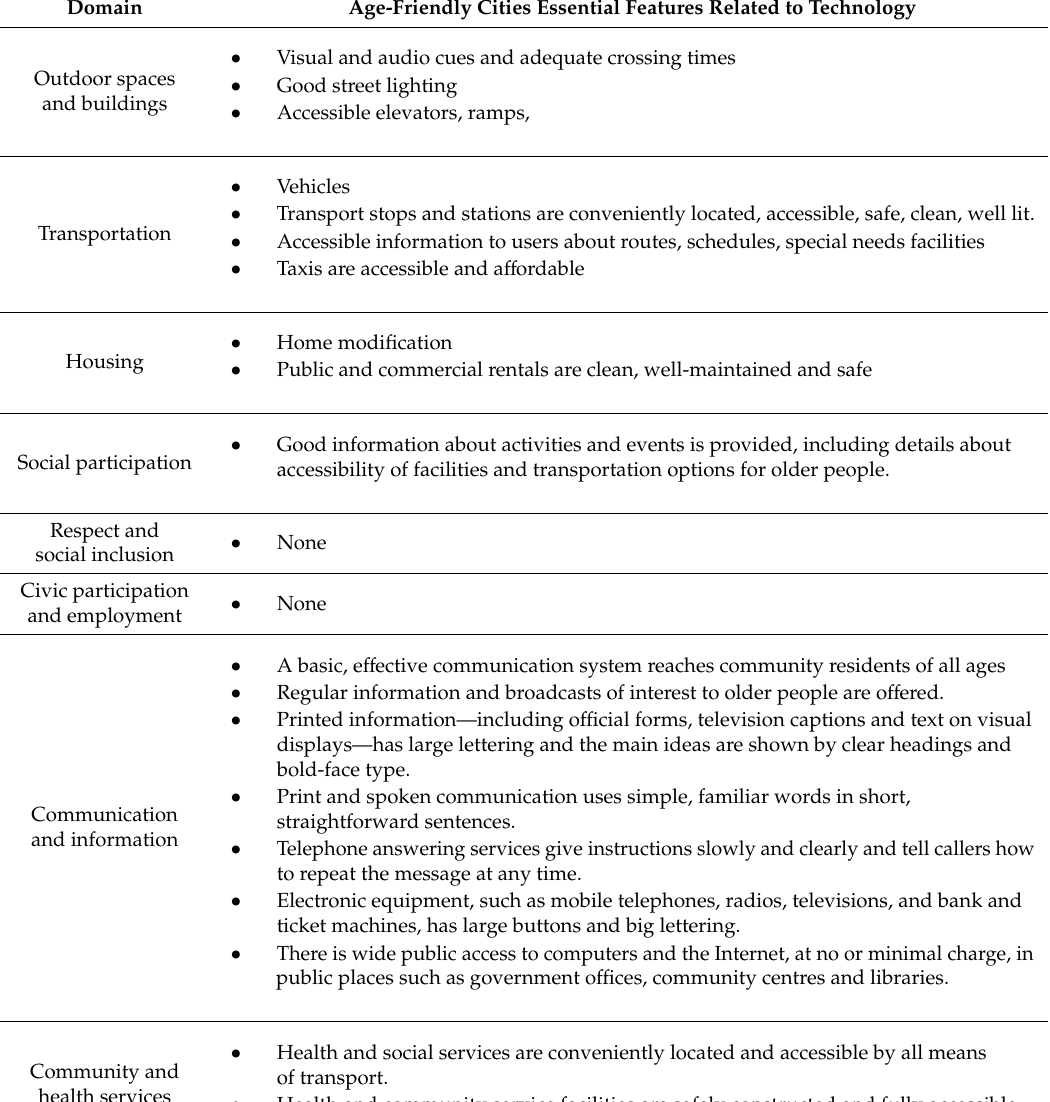
Table 1. Technology features across the eight domains of age-friendly cities